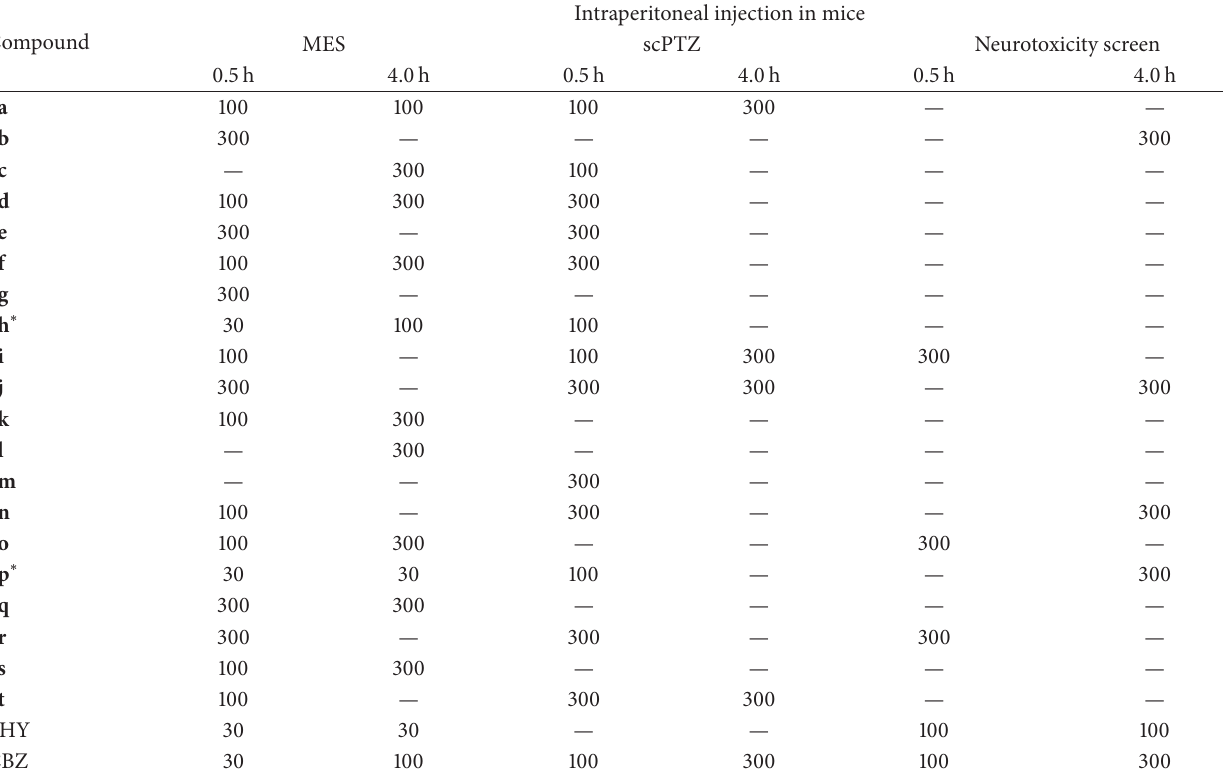
Table 2: Phase I anticonvulsant evaluation of the synthesized compounds ( 5a–t ). Compound